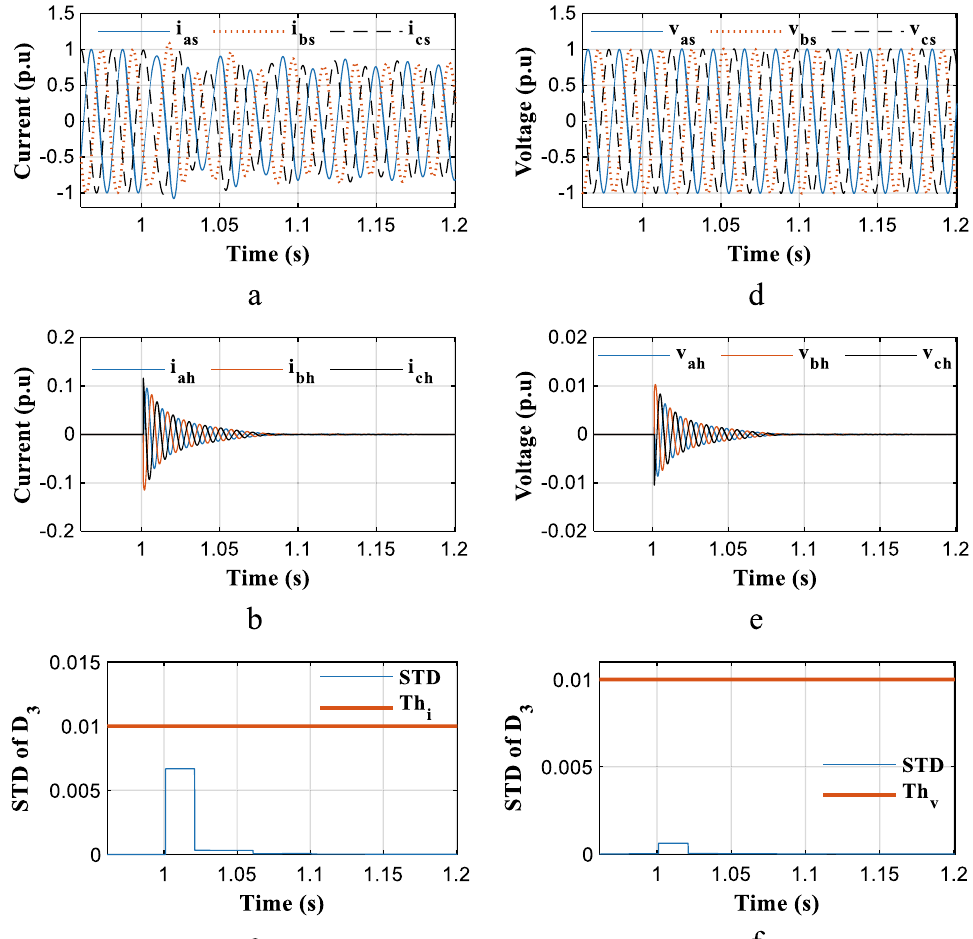
Fig. 14 Performance evaluation of proposed criteria using simulation results for a load rejection from 0.7 p.u to no load, a Three-phase stator current signals, b High-frequency components of three-phase stator current signals, c The current criterion, d Three-phase stator voltage signals, e High-frequency components of three-phase stator voltage signals, f The voltage criterion